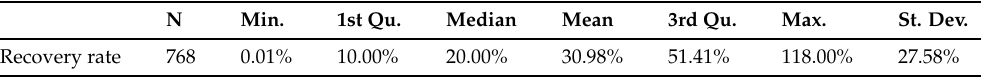
Figure 3. Histogram of recovery rates in our sample. The dashed line represents the sample mean. The average recovery rate is 30.98%, while the standard deviation is equal to 27.58, which is a large value compared to the mean. The distribution is also highly skewed, a typical feature of recovery rate data. Table 2. Summary statistics of our recovery rate